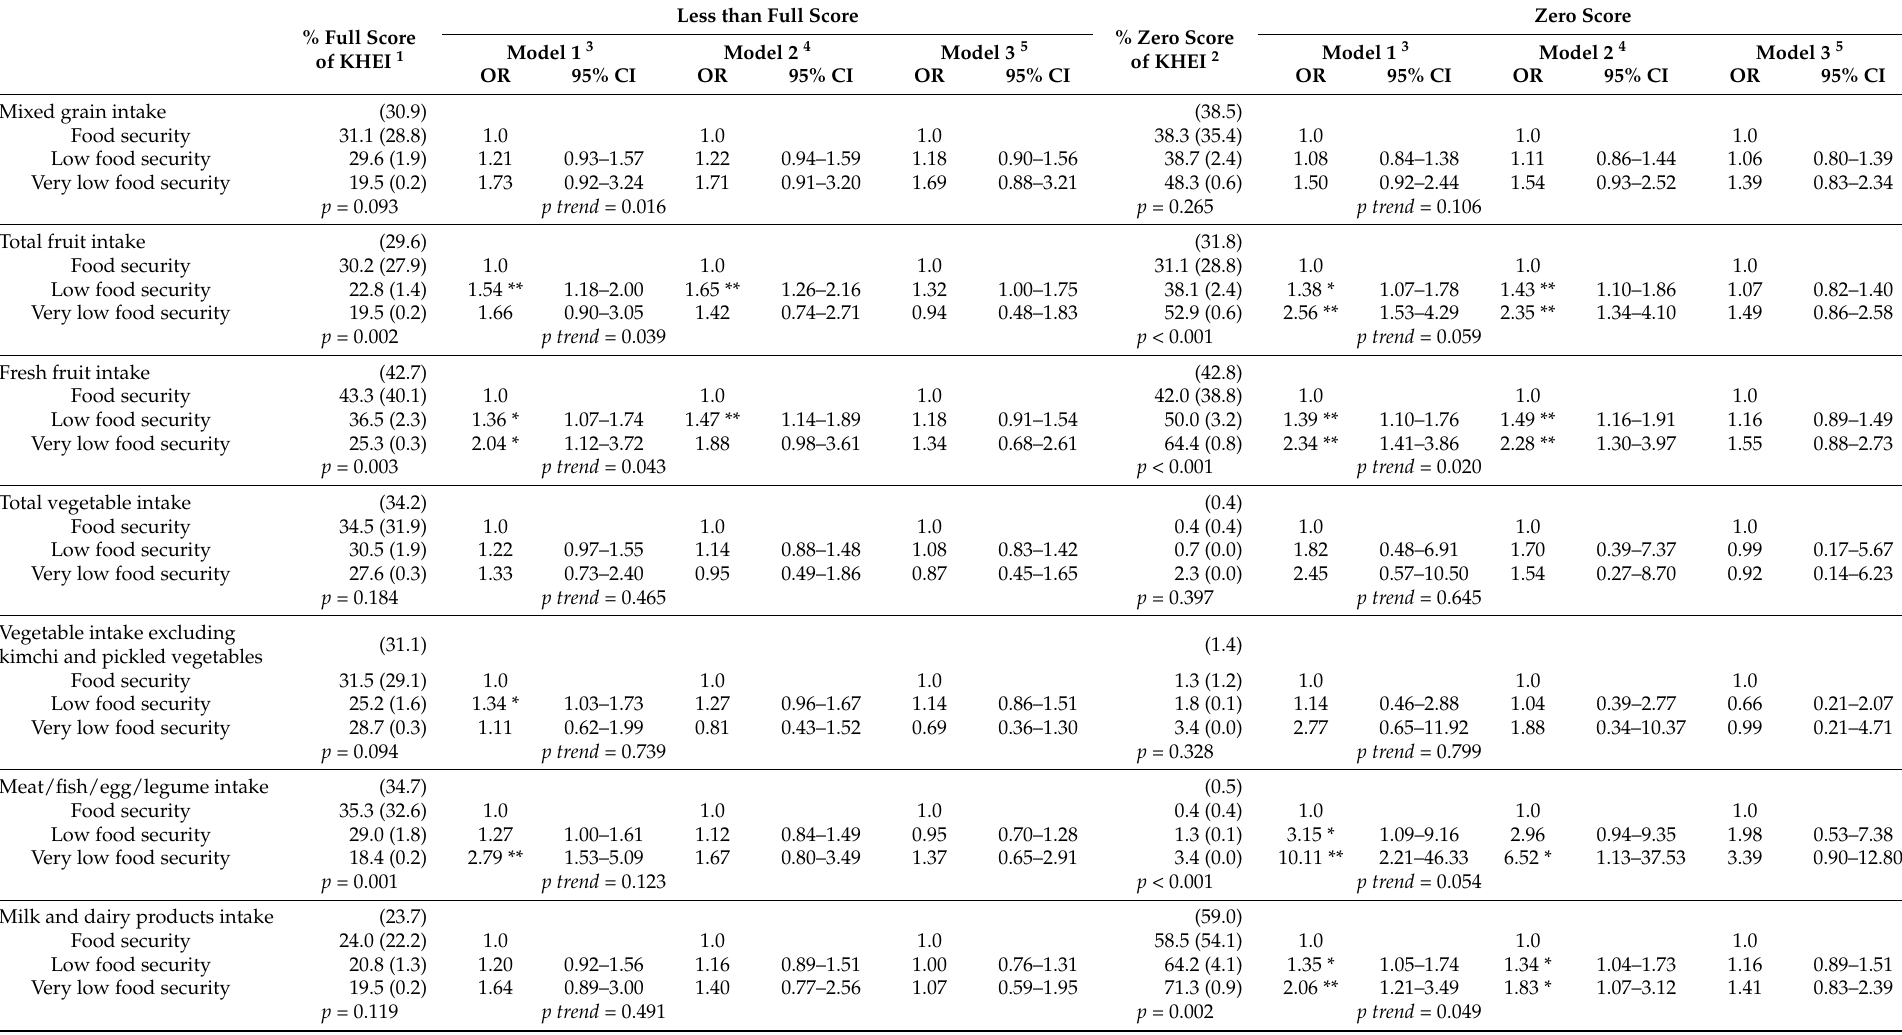
Table 4. Dietary quality measured by the KHEI according to household food security